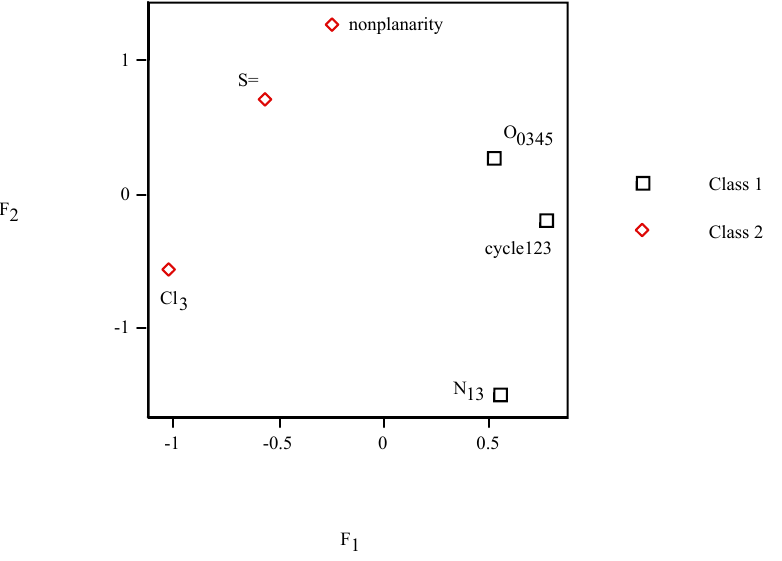
vs. F scores plot for the vector properties corresponding to 2 1